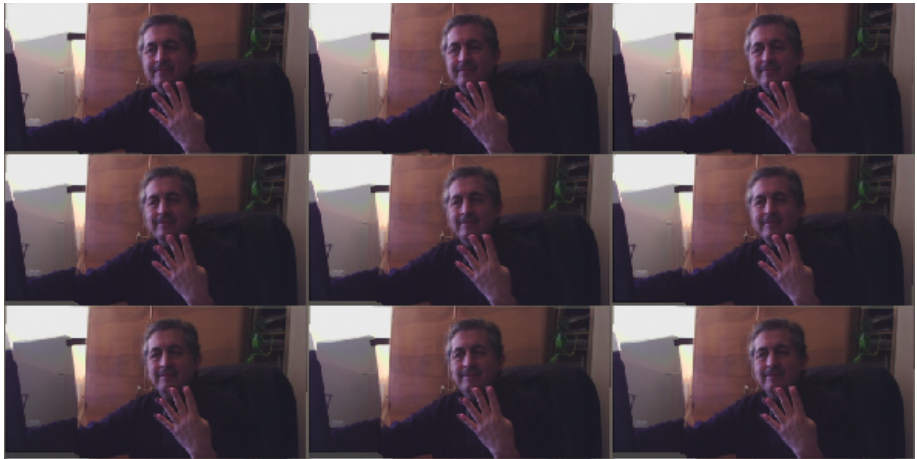
Figure 2. Central part of a 8 × 4 Quilt generated by morphing starting from the stereo images in Figure 1 via the torch-warp algorithm described in